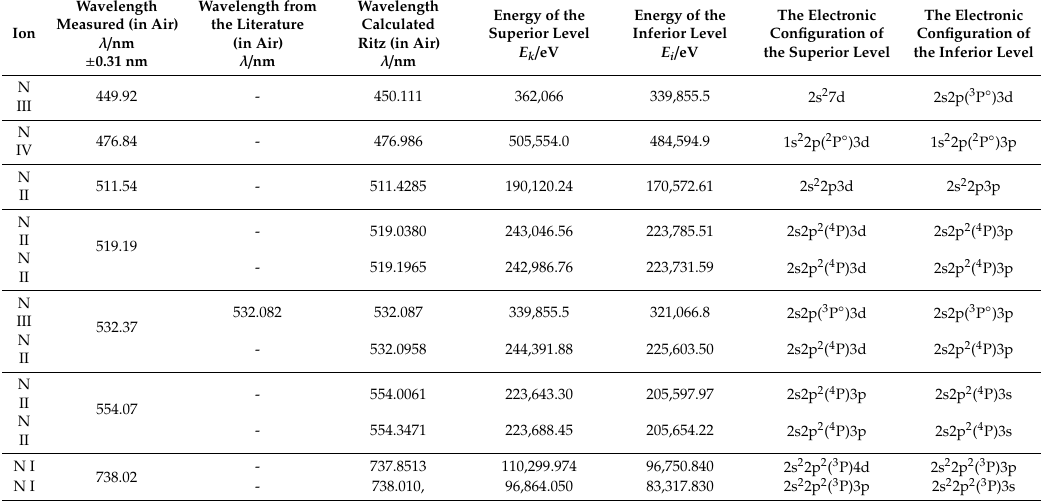
Table 7. Atomic nitrogen fluorescence (BTA in acetone solution with c = 1%).